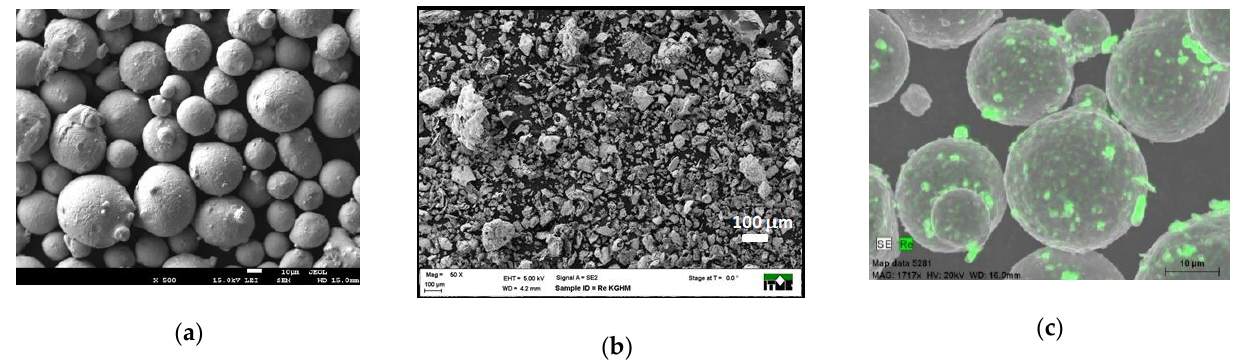
Figure 3. SEM micrograph showing particle size and morphology of ( a ) base powder Ni-20Cr, ( b ) Rhenium powder particles and ( c ) composite Ni-20Cr+Re particles (green color) after 4h of ball mills employed in this work.